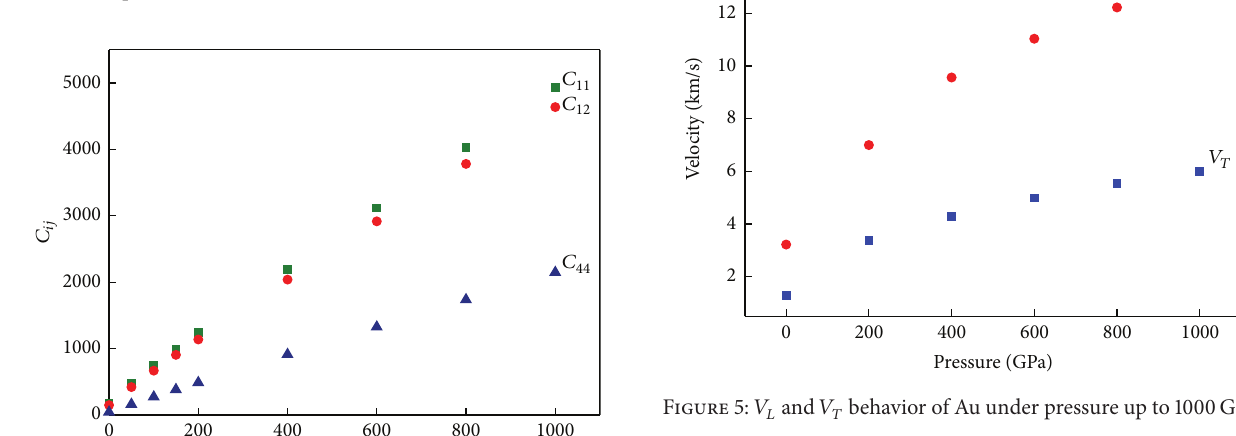
Figure 2: Comparing typical cubic elastic constants of Au as a function of pressure.